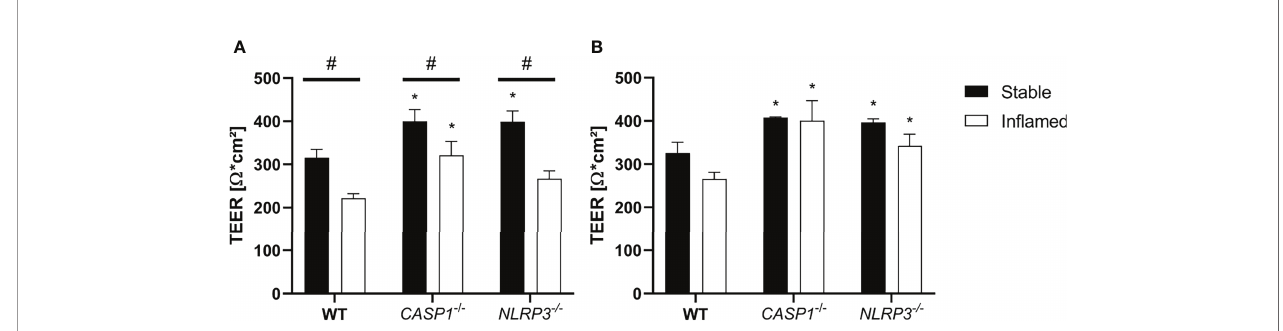
FIGURE 2 | TEER at (A) t=24 h and (B) t=48 h of stable (full bars) and in fl amed (open bars) triple-cultures with WT, CASP1 -/- or NLRP3 -/- THP-1 cells. Mean ± SD of N = 3; *p < 0.05, compared to the respective WT control; # p < 0.05 compared to the respective